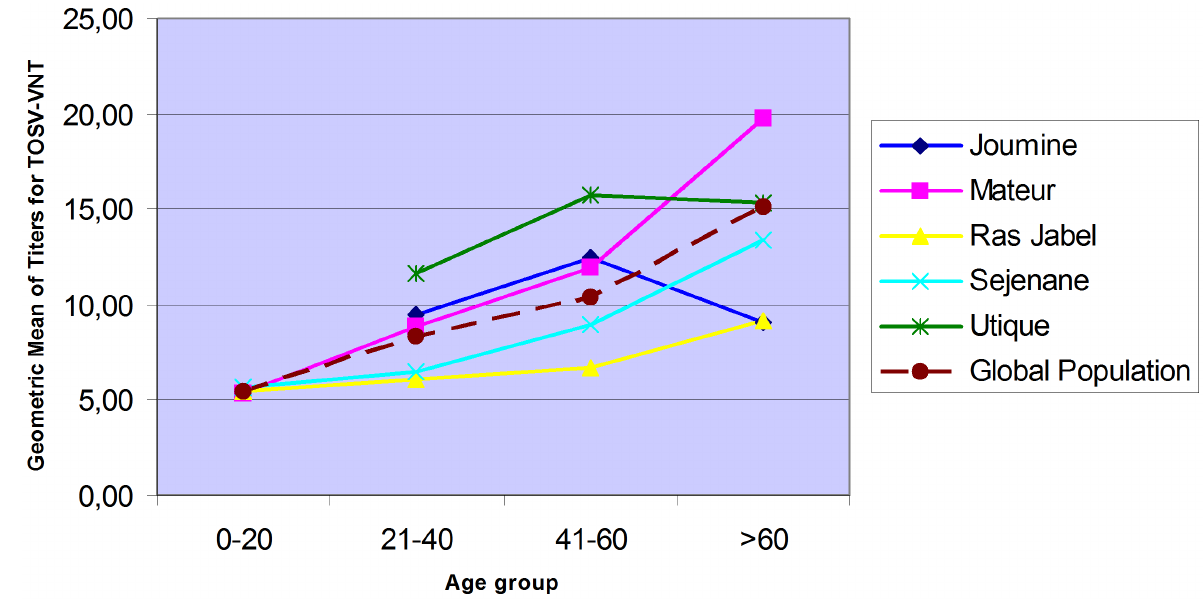
Figure 2. Geographic mean of titres for TOSV MN according to age groups. doi:10.1371/journal.pntd.0002429.g002 PLOS Neglected Tropical Diseases |